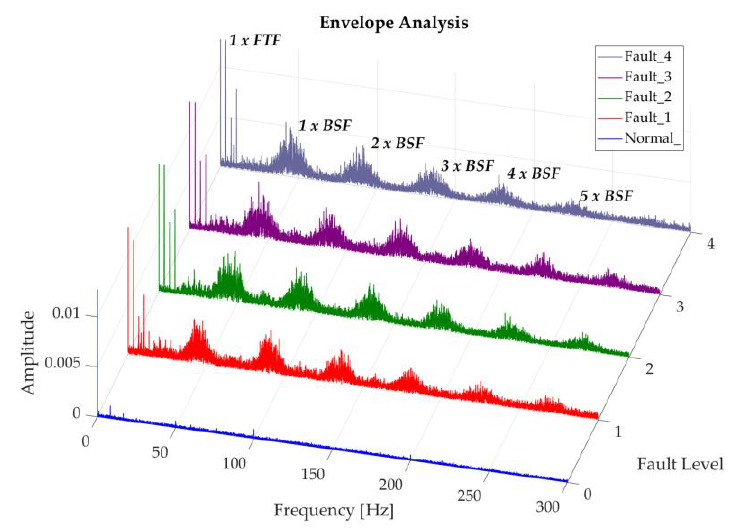
Figure 18. Representation of recordings of rolling element degradation at 500 rpm.